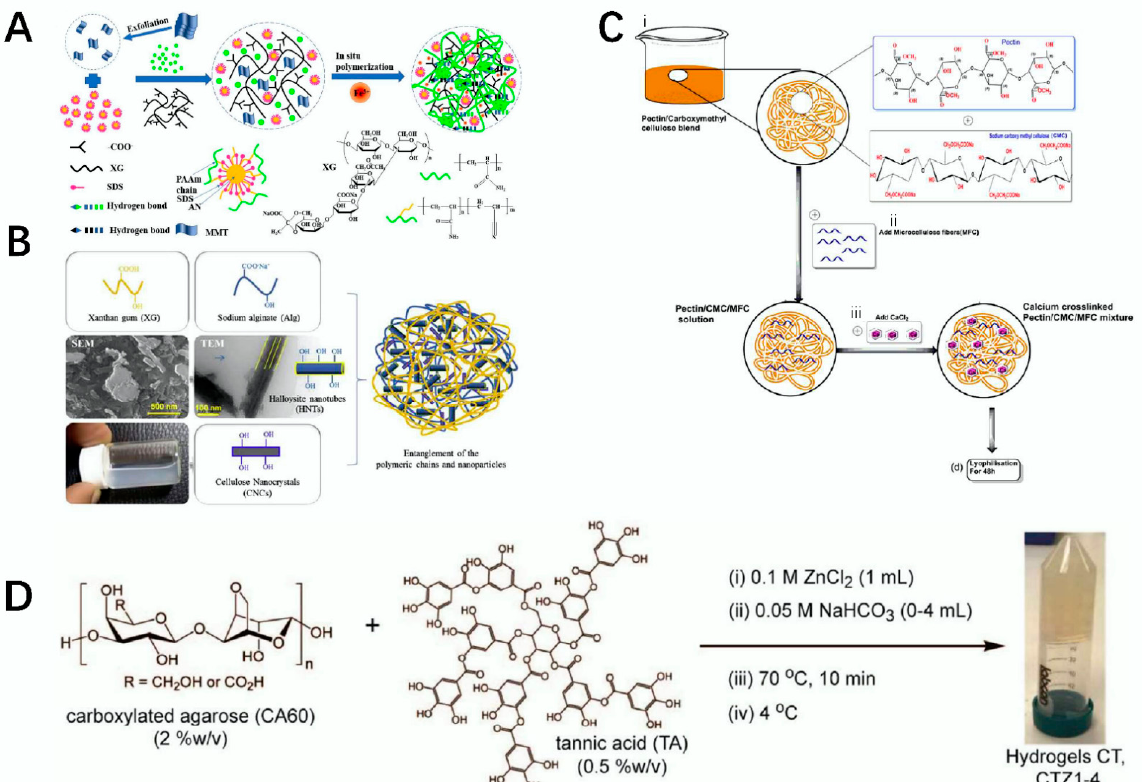
Figure 3. Schematic diagram of the synthesis of polysaccharide materials. ( A ) schematic diagram of the preparation of the XG/MMT/PAAm hydrogel modified by Fe 3+ [45]. ( B ) schematic diagram of the preparation of the AlgX–CNCs–HNT composite scaffold [44]. ( C ) schematic diagram of the preparation of pectin/CMC/MFC scaffolds [46]. ( D ) schematic diagram of the